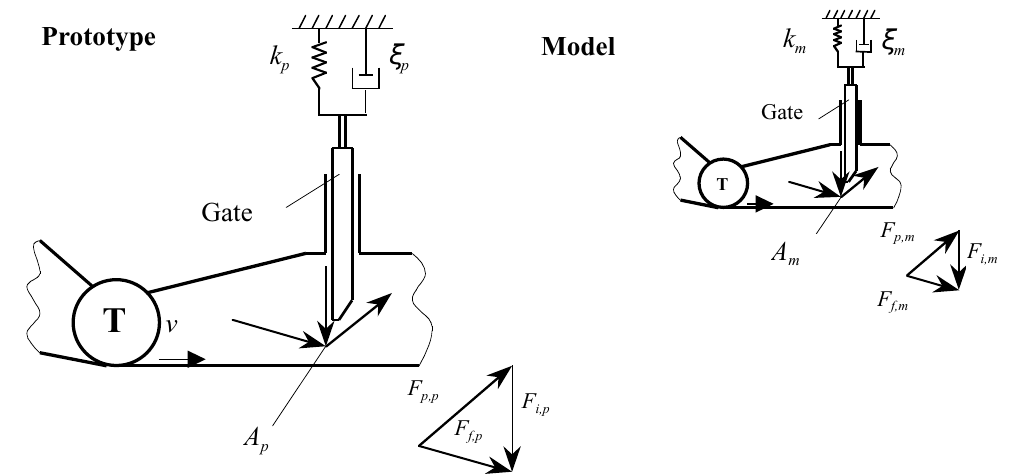
Fig. 12. Gate – model and prototype and kinematically similar